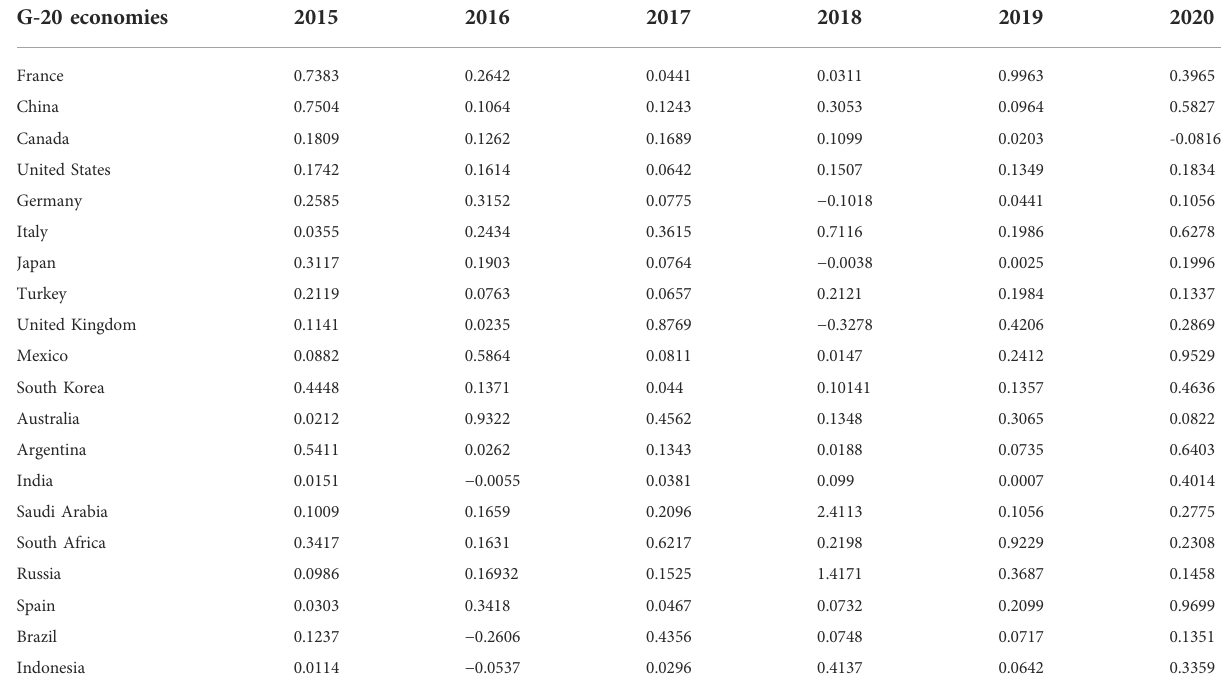
TABLE 3 Energy Price Risk estimation through